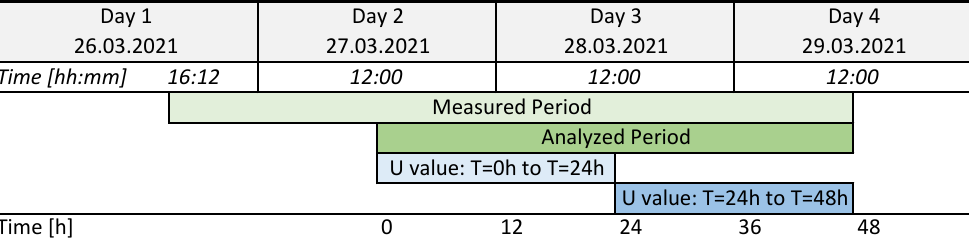
Figure 6. Schematic timeline for the data evaluation of the heat flux measurements (measurement cycle 2) according to the average method (ISO 9869-1:2014); showing the measured period (light green), the analyzed period (dark green), and the respective subdivided time periods (blue).